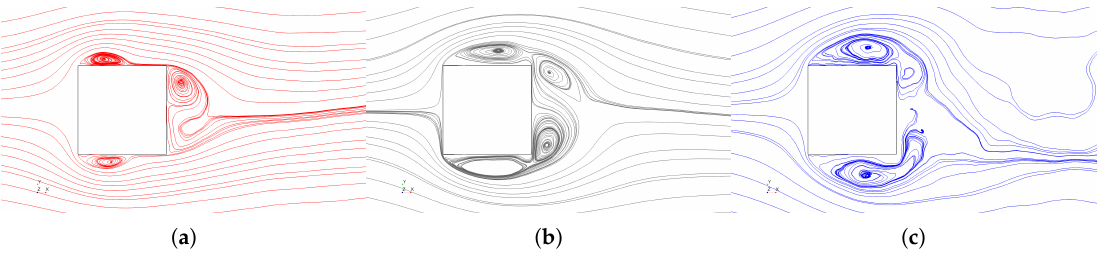
Figure 10. Streamlines at cylinder center plane for: ( a ) 0 < a x ; ( b ) a x = 0; and ( c ) a x < 0.